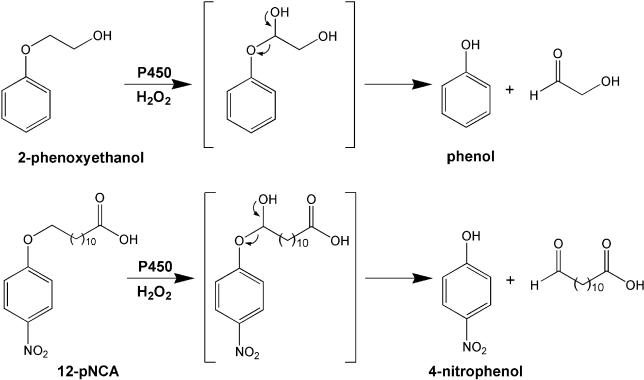
Substrates and Major Products of P450 Peroxygenase Reactions with 2-Phenoxyethanol and p-Nitrophenoxydodecanoic Acid (12-pNCA)In both cases, hydroxylation yields a hemiacetal which decomposes to phenolic products detectable in high-throughput assays.